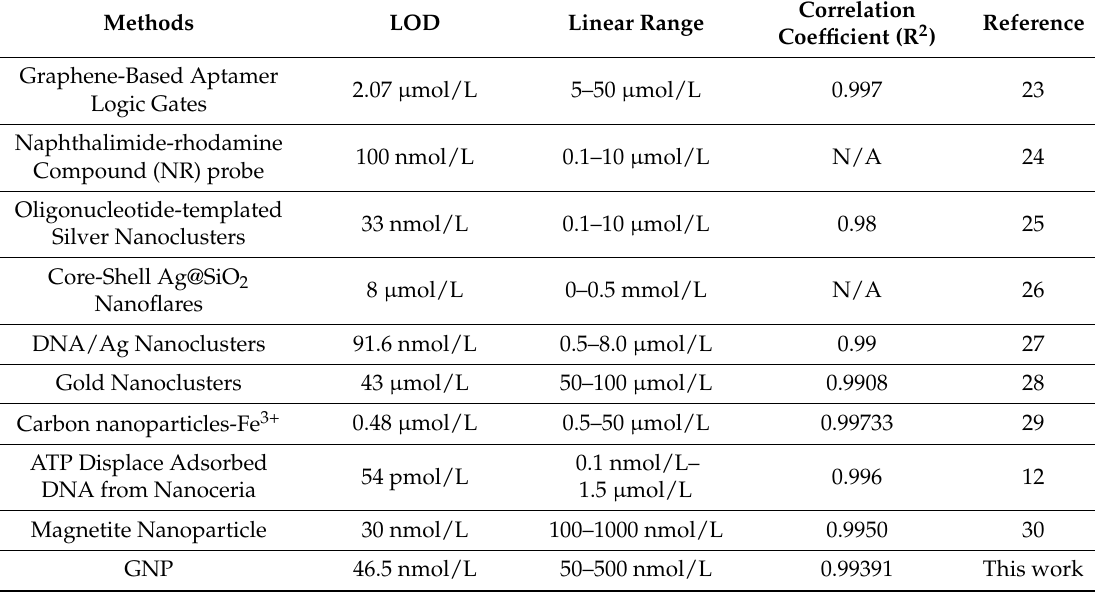
Figure 3. ( A ) Fluorescence emission spectra at various ATP concentrations. ( B ) Linearity for detection of ATP. Table 1. Other methods for ATP detection.